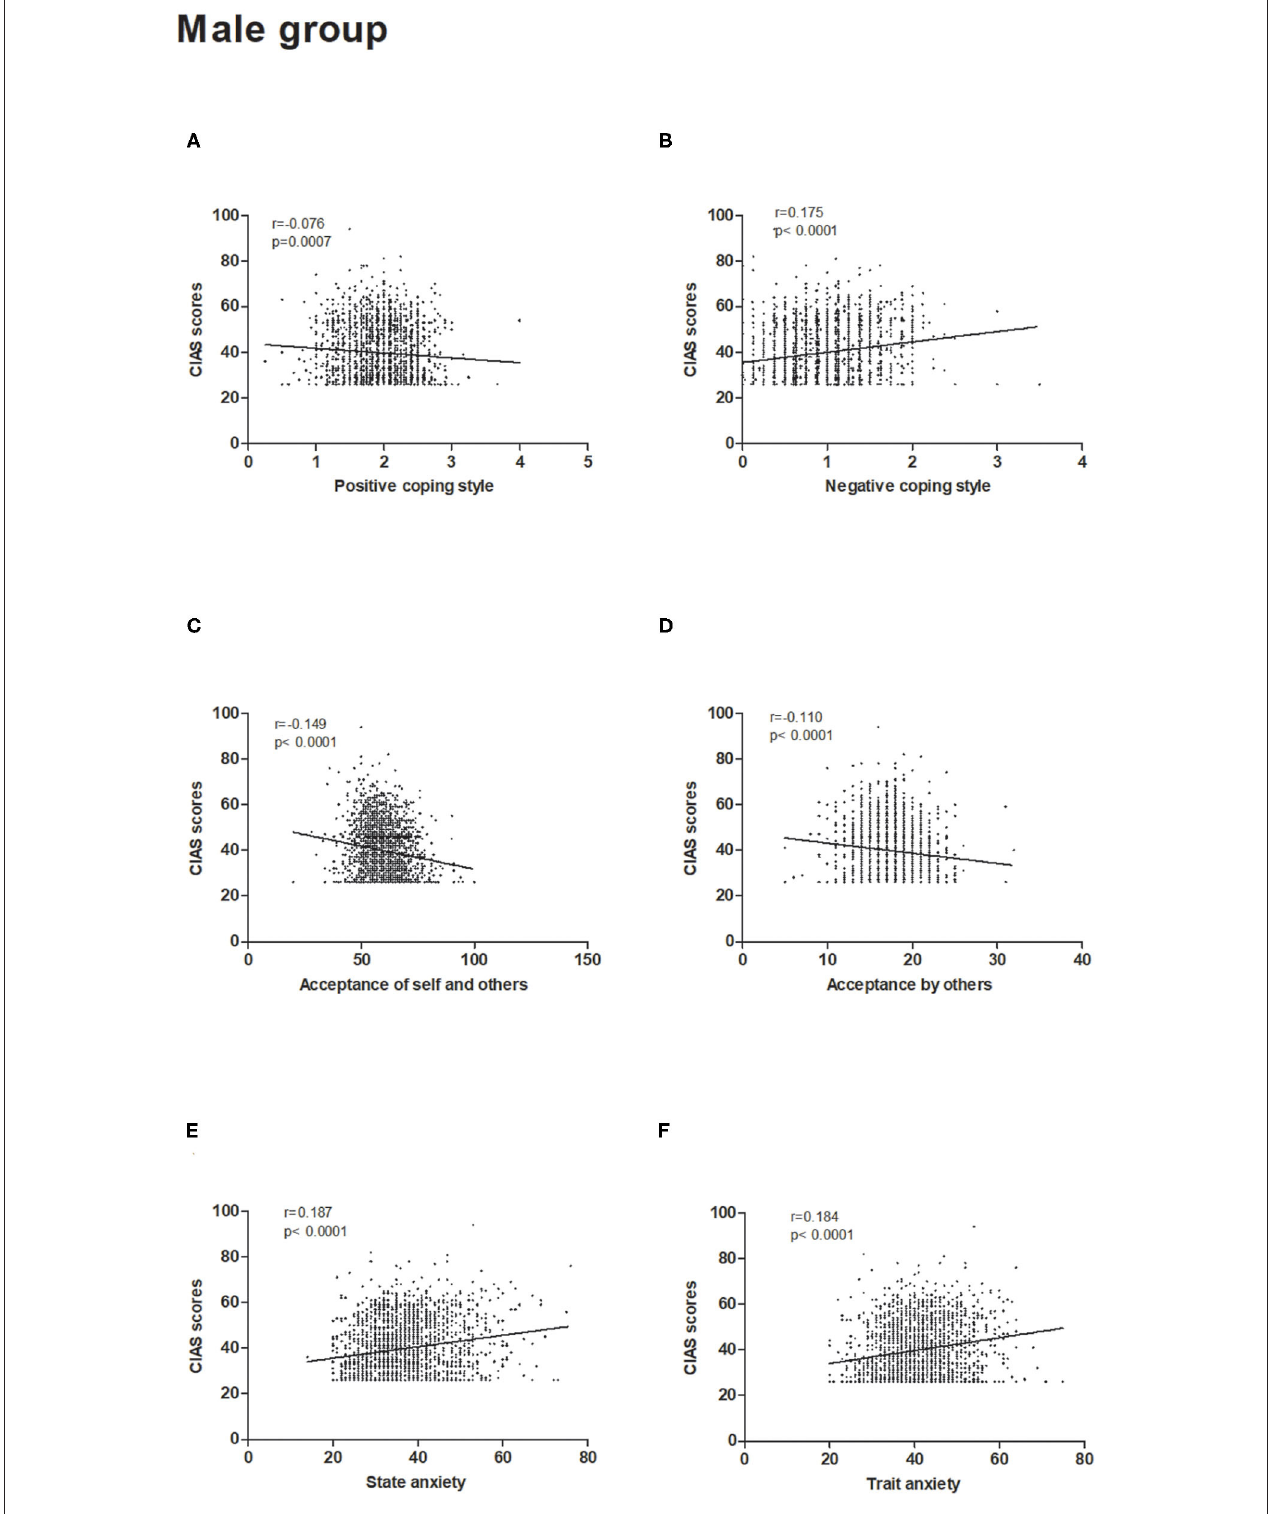
FIGURE 1 | Correlations between the severity of Internet addiction and psychological characteristics in the male group. (A,C,D) Negative correlations were observed between CIAS scores and acceptance of self and others, acceptance by others and positive coping style. (B,E,F) Positive correlations were observed between the CIAS scores and negative coping style, state anxiety and trait anxiety. CIAS, Chinese Internet Addiction Scale.